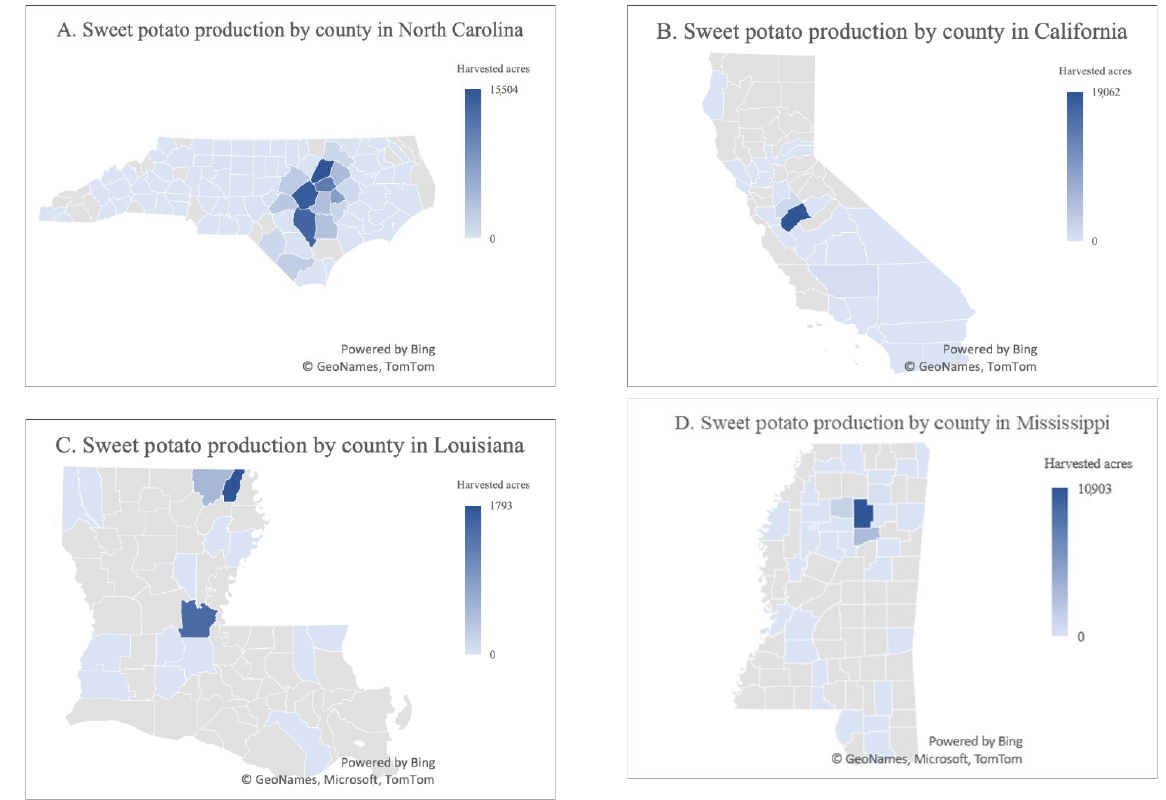
Figure 2. Sweet potato producing counties in North Carolina, California, Louisiana, and Mississippi. Horticulturae 2022 , 8 , x FOR PEER REVIEW Map created in Excel, Powered by Bing, © GeoNames, Microsoft, TomTom.